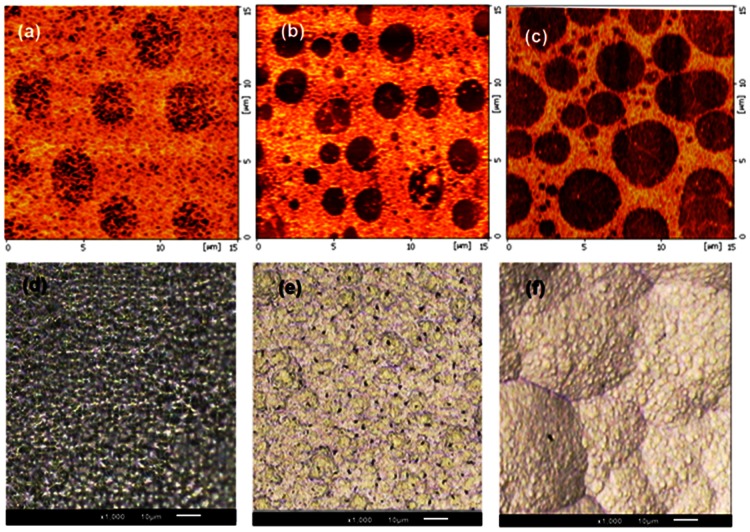
AFM images of the Si surface etched with KOH: (a) 10%wt (b) 20%wt (c) 30%wt, and SEM images of Si surface etched with 30%wt.
KOH +10%vol IPA at : d) 50°C (e) 60°C, (f) 80°C.